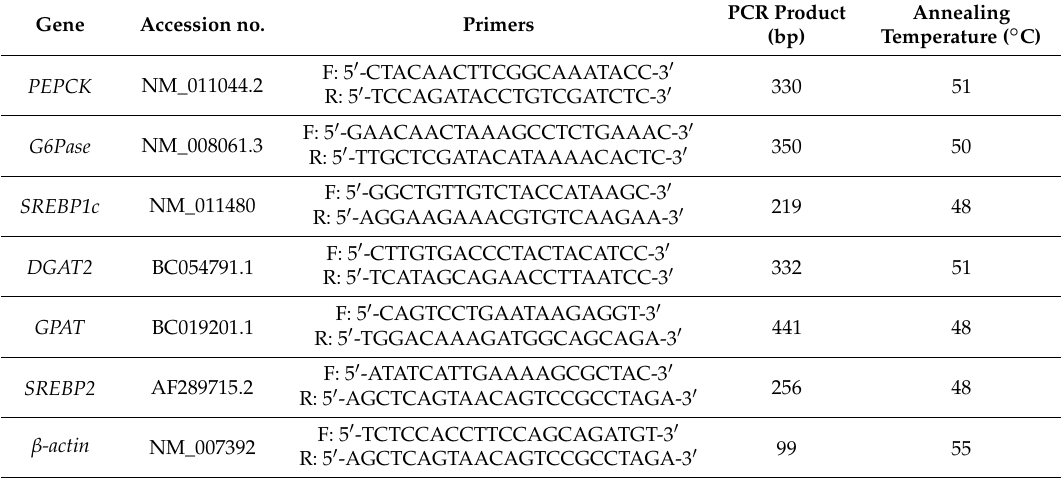
Table 2. Primers used in this